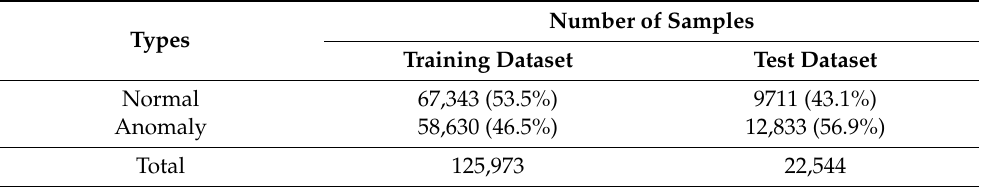
Table 4. Distribution of NSL-KDD